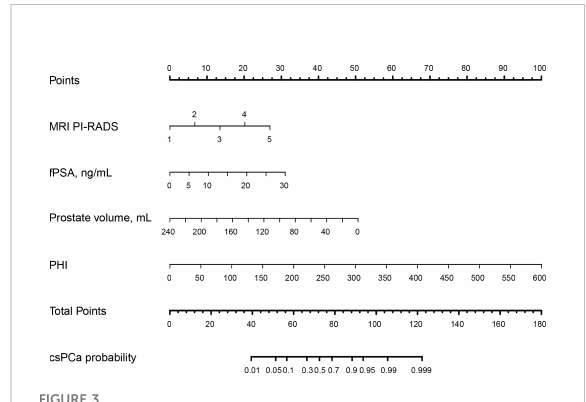
FIGURE 3 The nomogram was employed by determining the patient ’ s location on each factor axis. The scores for each element are summed to obtain a total score, which is depicted on the lower axis and corresponds to the likelihood of csPCa. PI-RADS, Prostate Imaging Reporting and Data System; fPSA: free PSA; PHI: prostate health index; tPSA: total PSA; csPCa: clinically signi fi cant prostate cancer. .